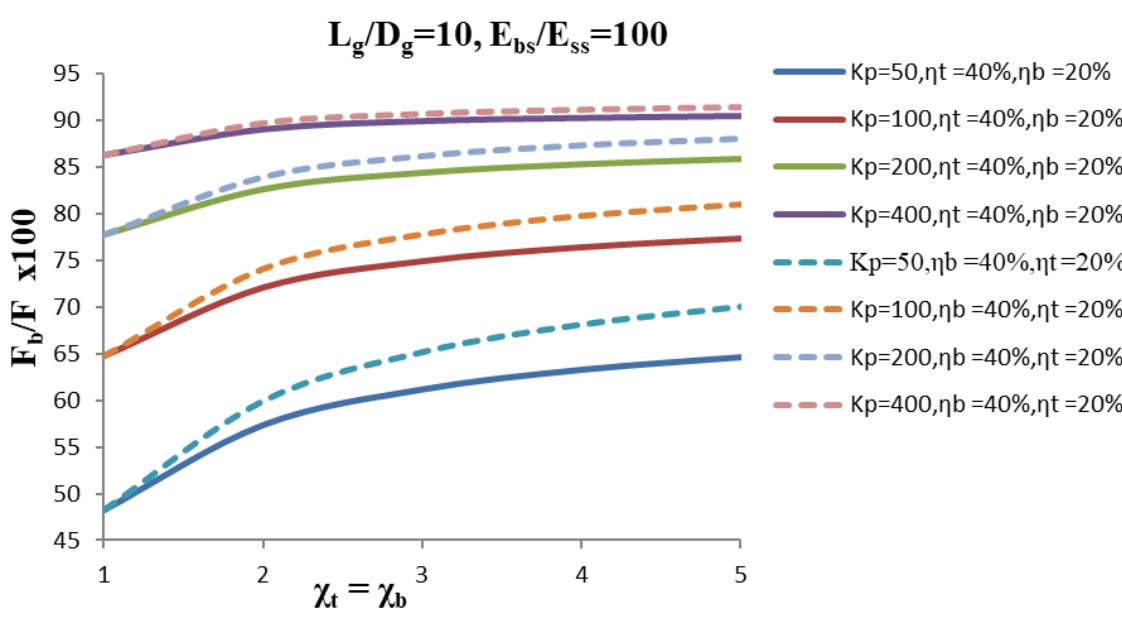
/F)x100 with strengthening factor for the top, χ b ; PLST of GP, η p